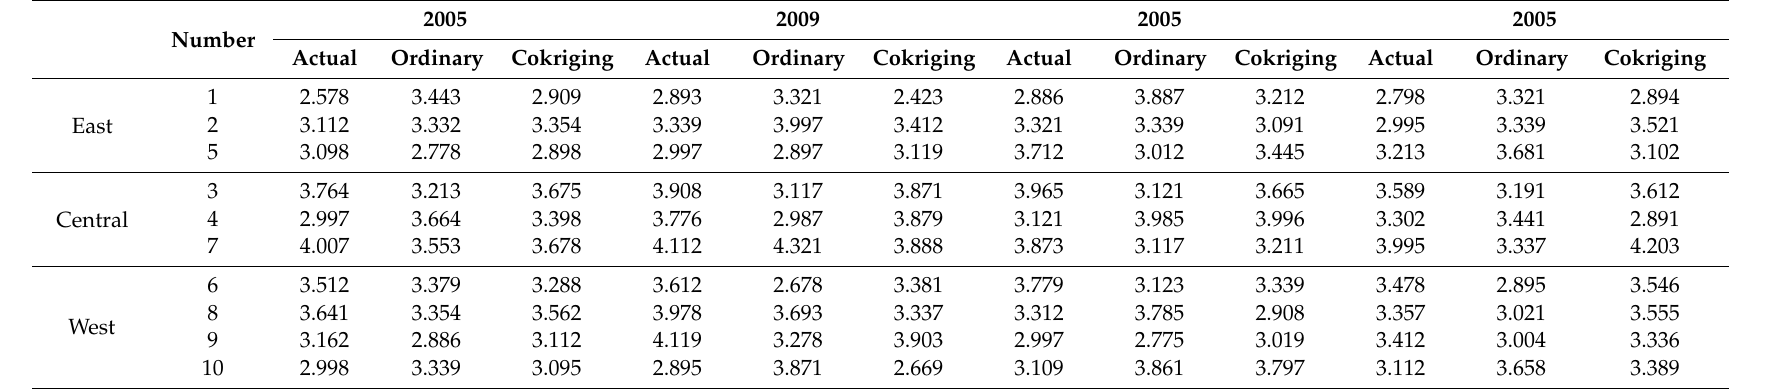
Table 3. Model partition accuracy